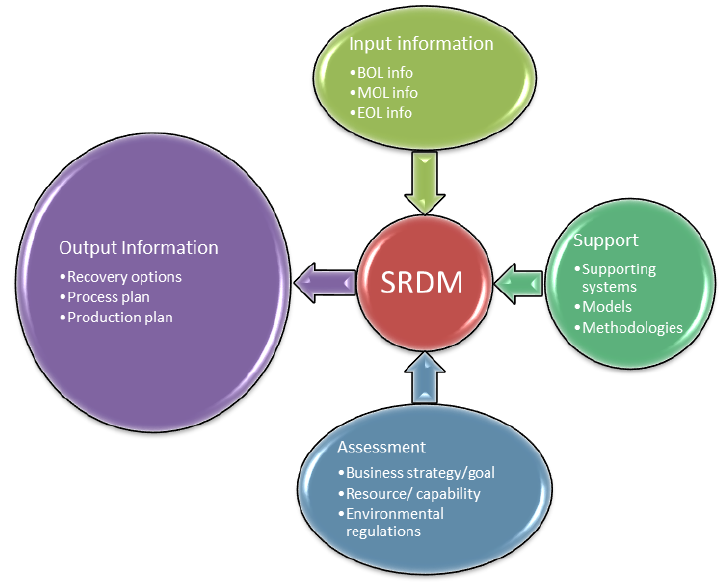
Figure 8. Information flow in an operational SRDM .